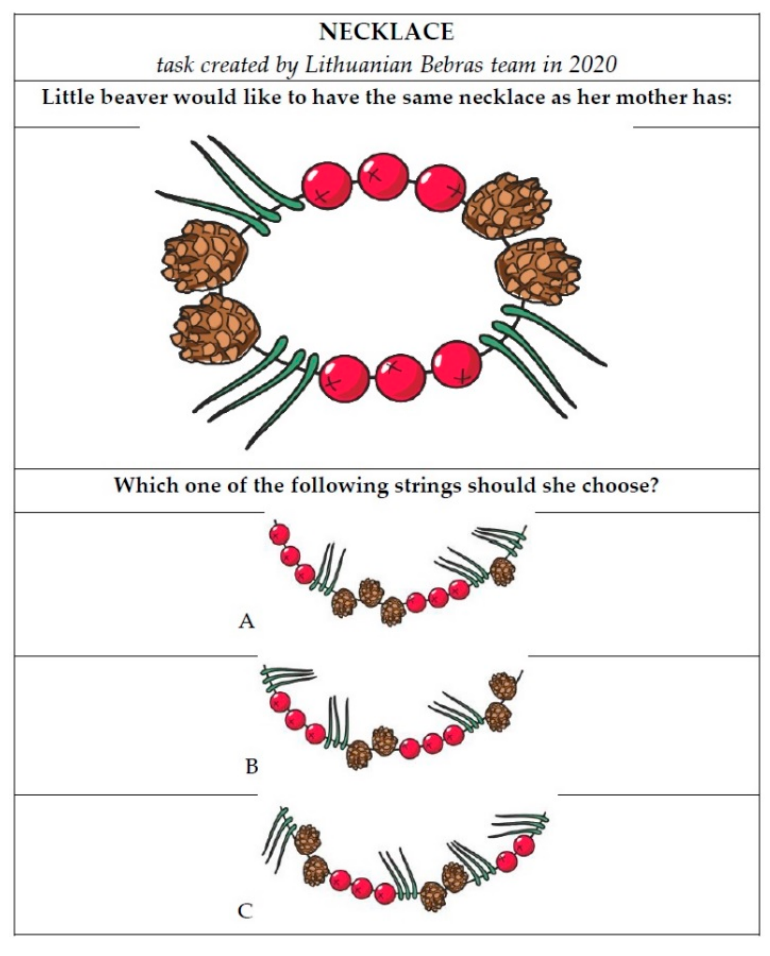
Figure 1. Short Bebras task for younger children. Labels A, B, C denote answer choices. Adapted from www.bebras.org (accessed on 24 February 2022).